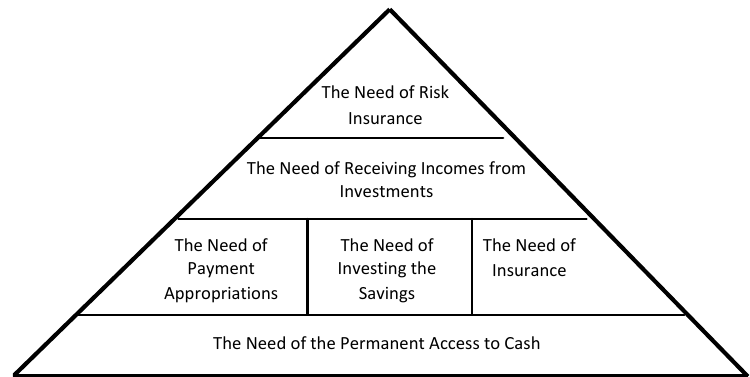
Fig. 2. The hierarchy of consumers’ financial needs (Smyczek,